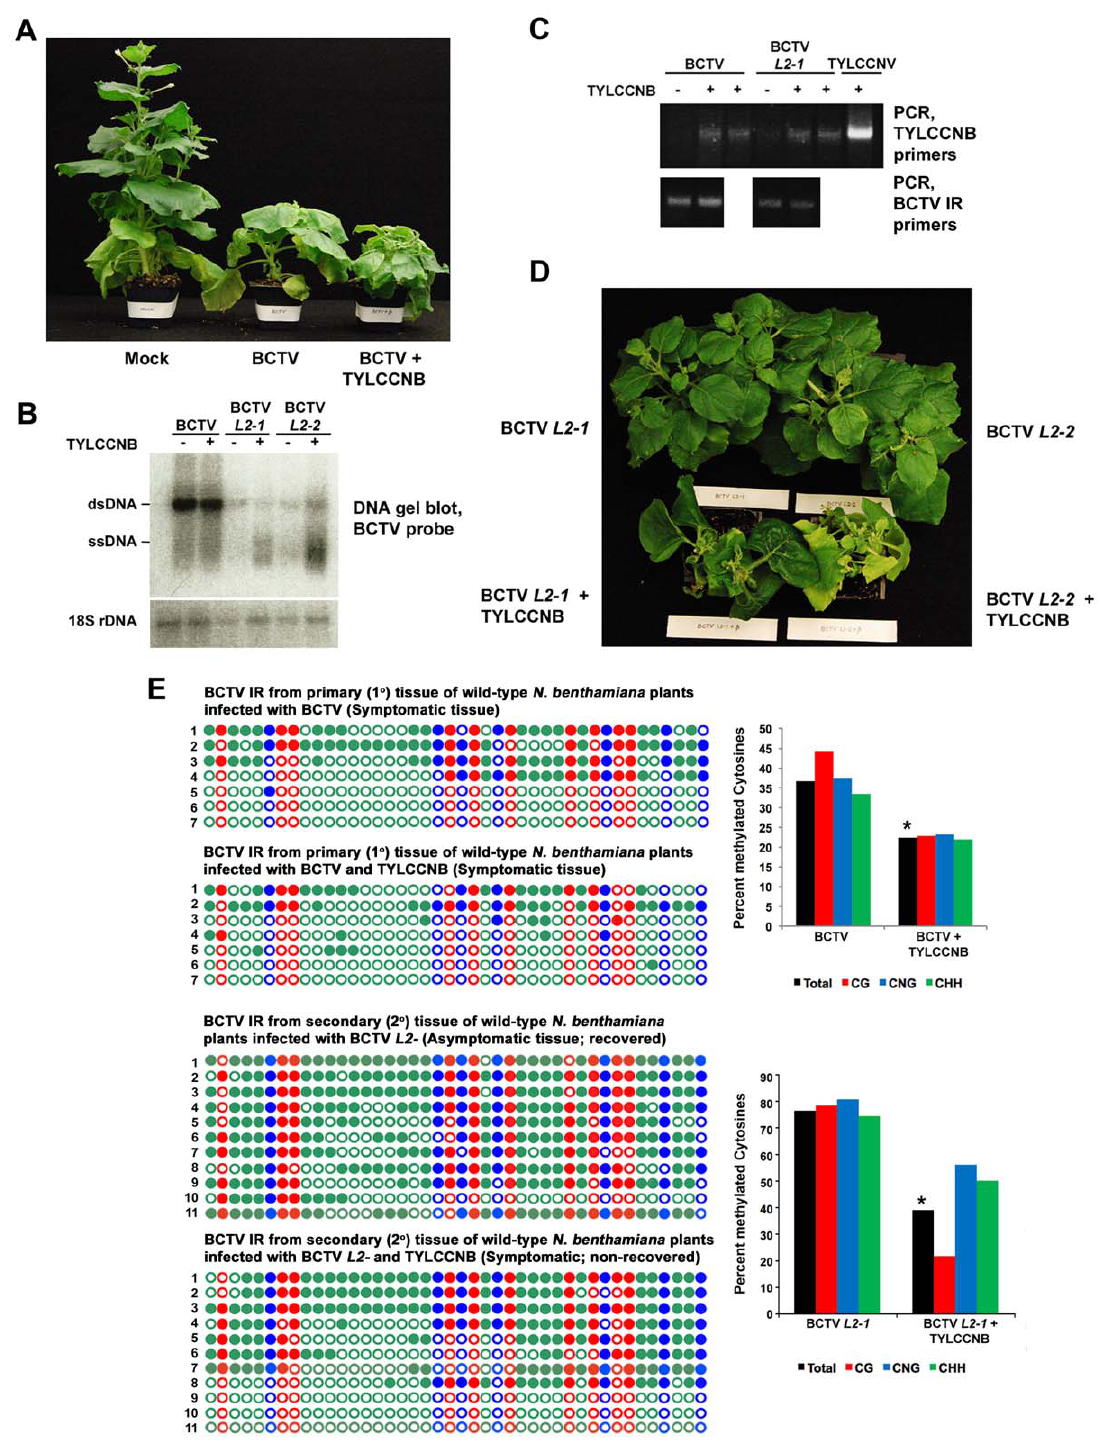
Figure 2. TYLCCNB complements BCTV L2 - mutants. (A) TYLCCNB imparts characteristic symptoms when co-inoculated with BCTV. N. benthamiana plants were mock inoculated, or inoculated with BCTV or BCTV + TYLCCNB and photographed 21 to 30 days later. (B) DNA gel blot hybridization analysis of BCTV DNA from primary tissue, and BCTV L2-1 and L2-2 DNA from recovered or non-recovered secondary tissue. BCTV and BCTV L2 - mutants were inoculated alone or with TYLCCNB, as indicated. DNA extracts were prepared from pools of at least six plants and digested with ScaI to linearize the viral genome and cleave host genomic 18S rDNA to provide a loading control. Viral single- and double-stranded DNAs (ssDNA, dsDNA) are indicated. (C) PCR detection of BCTV and TYLCCNB DNA in infected plants. An ethidium bromide stained gel of PCR products obtained with TYLCCNB- or BCTV intergenic region (IR)-specific primers is shown. Plants were inoculated as indicated. (D) TYLCCNB complements BCTV L2 - mutants and prevents host recovery. Plants were inoculated with BCTV L2-1 or L2-2 mutants alone, or with TYLCCNB. Symptomatic, primary infected tissues were removed 21-30 days post-inoculation, after which secondary shoots were allowed to grow for 14-21 days. Plants were photographed from above to reveal the extent of recovery in virus inoculated plants, and absence of recovery in co-inoculated plants. (E) Cytosine